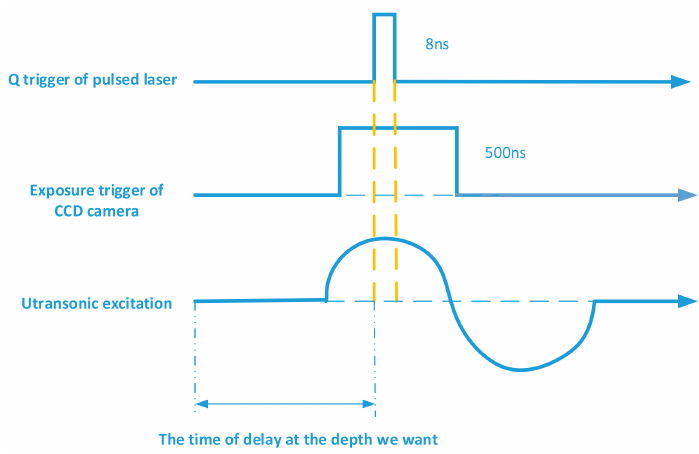
Figure 6. Synchronous control timing diagram (CCD: Charge-coupled Device).